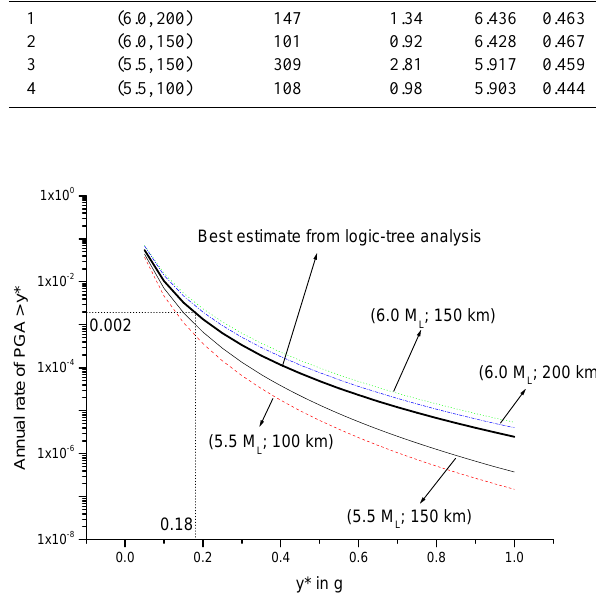
Fig. 7. The sensitivity analysis on the magnitude and distance thresholds and the best-estimate hazard curve for the site with a logic-tree analysis accounting for such uncertainty in the analysis.